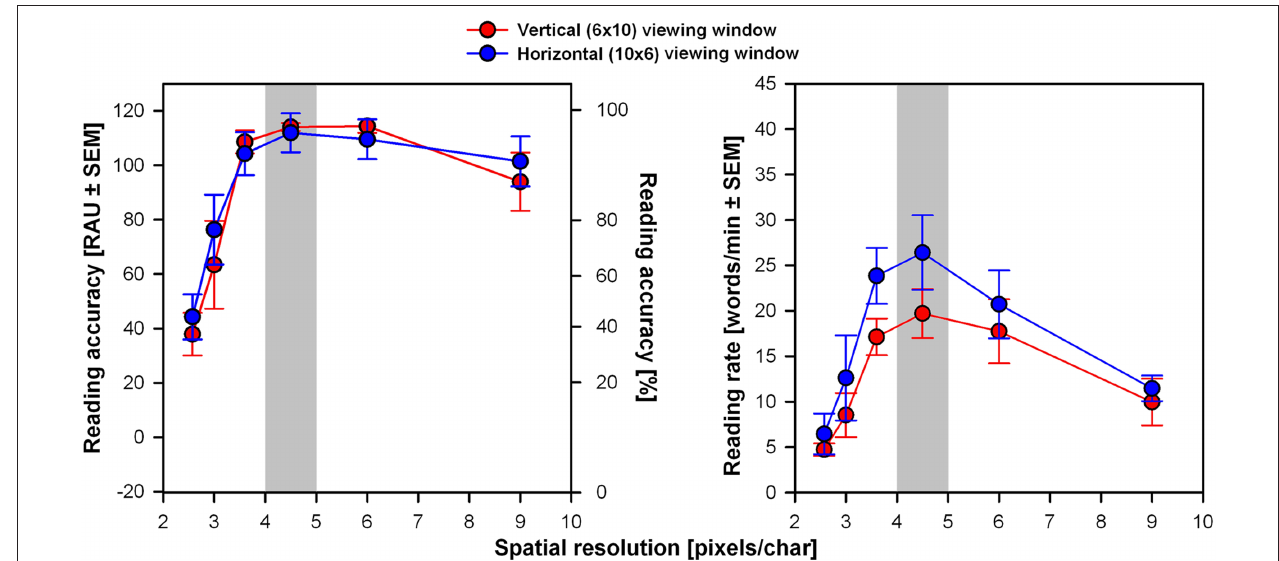
Figure 4 | Mean reading performance for all subjects versus spatial resolution (pixels/char). Results were calculated across all the three trials performed in each condition. The gray bars correspond to the optimum resolution range found in